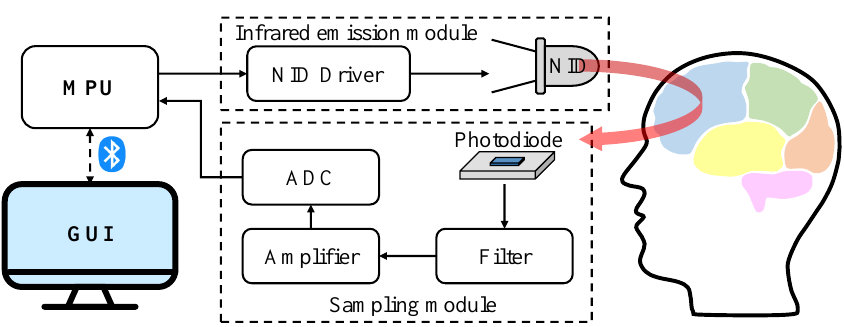
Figure 1. The schematic diagram of the designed system